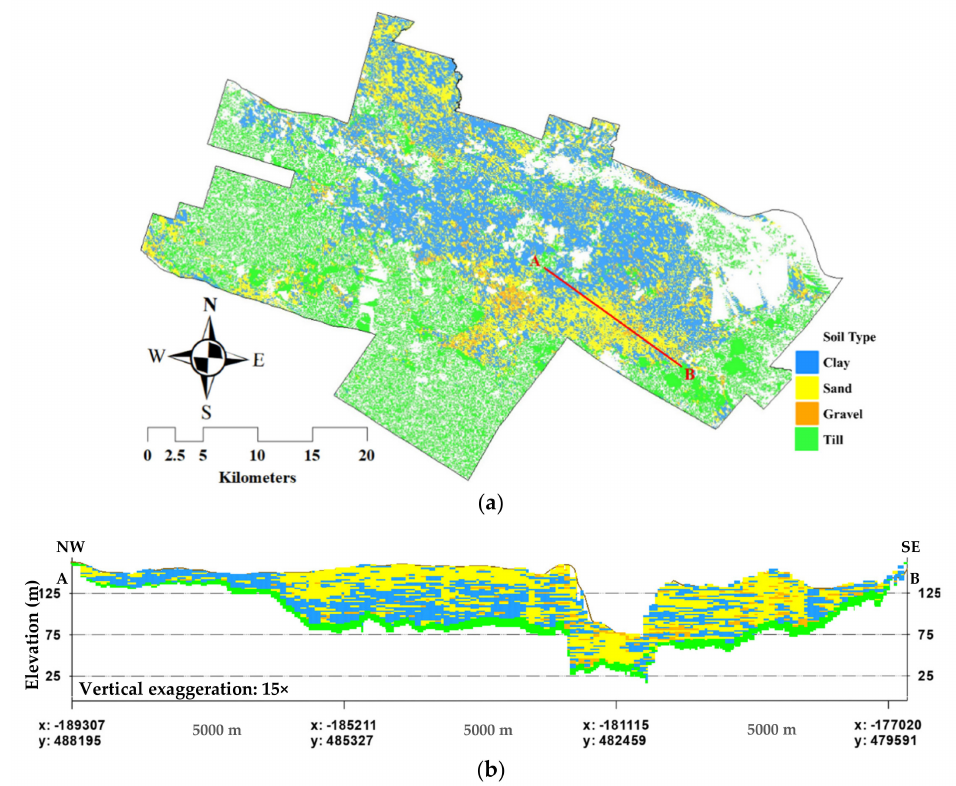
Figure 12. ( a ) Plan and ( b ) cross-section of one SIS realisation of sand, clay and gravel. The thickness of the till unit shown in the cross-section is determined in Section